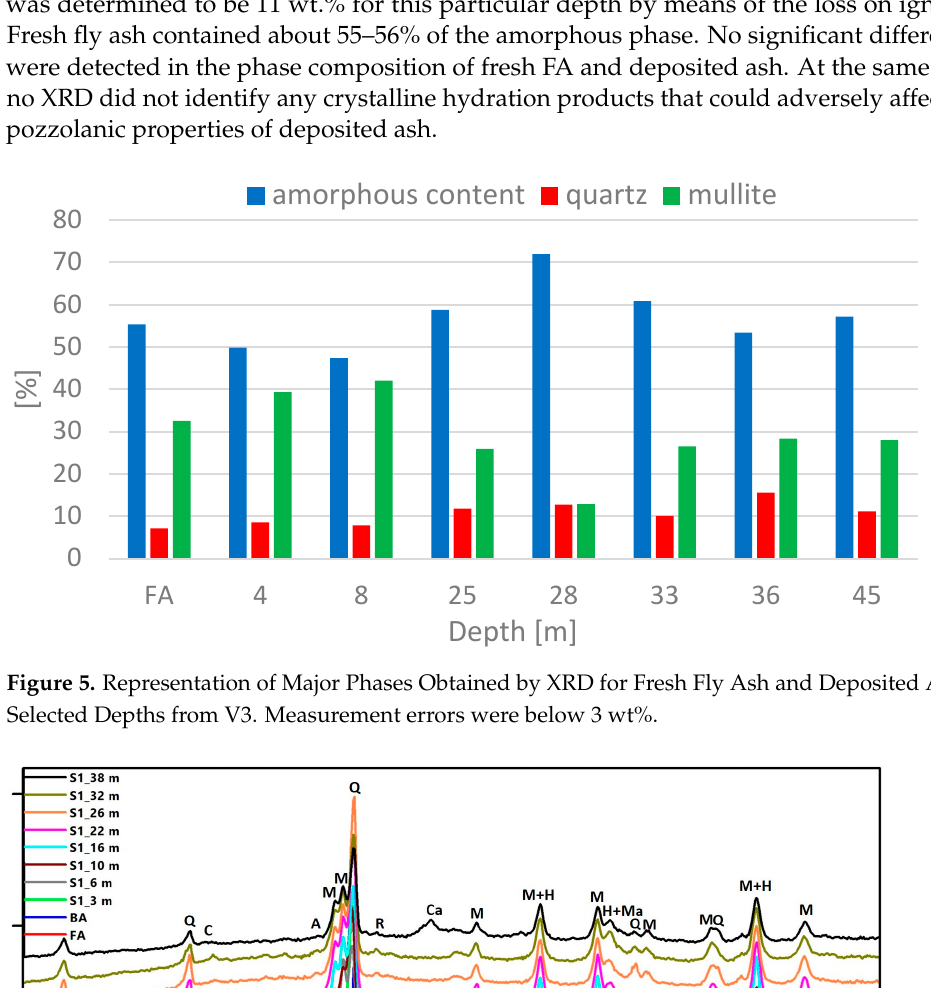
Figure 5. Representation of Major Phases Obtained by XRD for Fresh Fly Ash and Deposited Ash at Selected Depths from V3. Measurement errors were below 3 wt%.